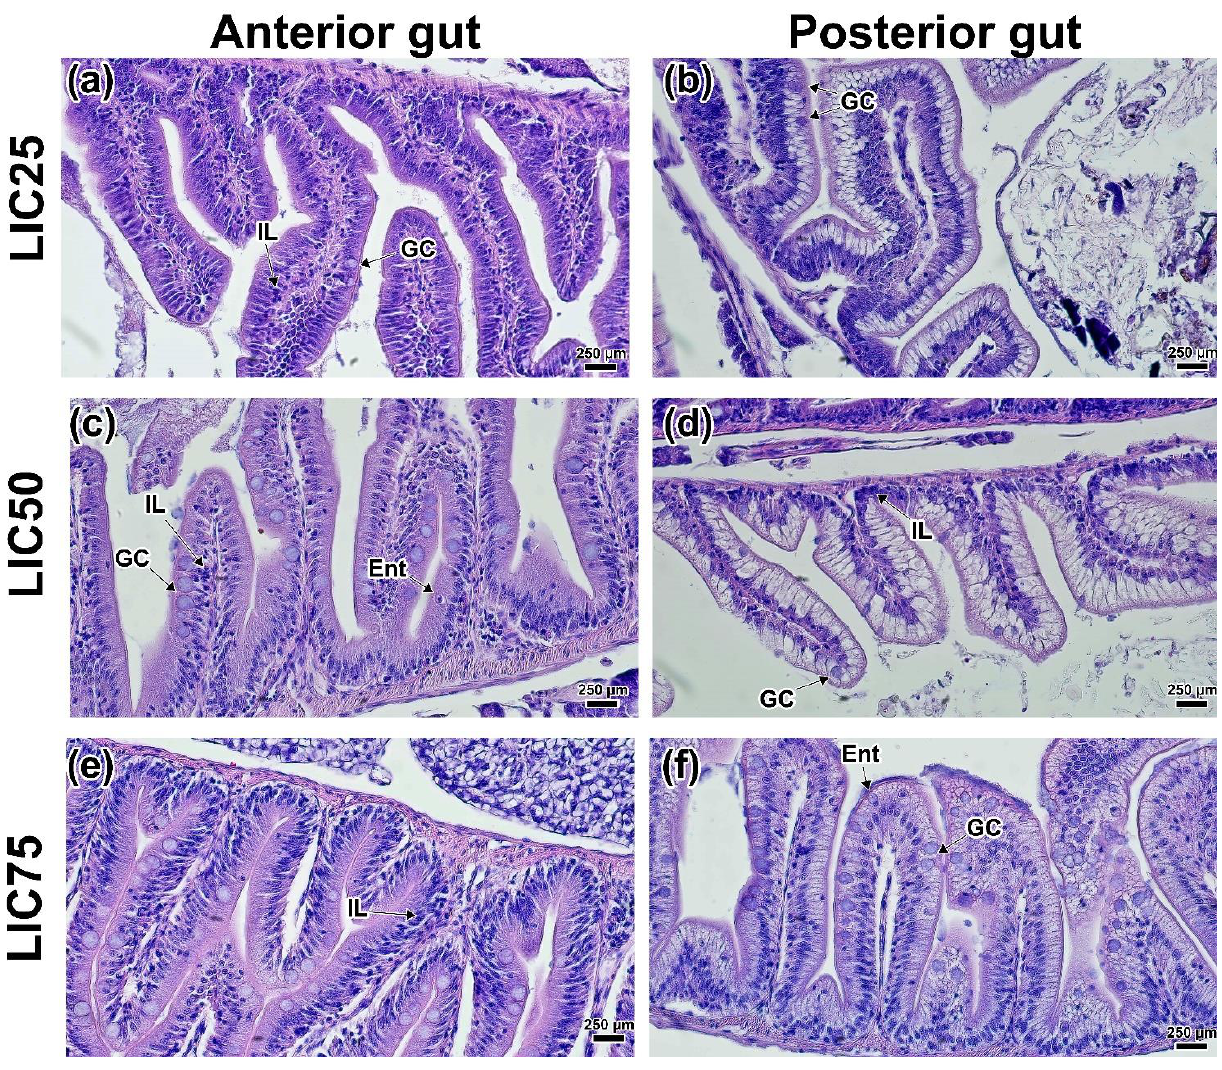
Figure 6. Histology of the anterior ( a , c , e ) and posterior ( b , d , f ) intestines of the D. rerio experimental groups receiving lycopene: ( a , b ) LYC25 group; ( c , d ) LYC50 group; ( e , f ) LYC75 group. LP — Lamina propria; GC — goblet cells; EN — epitheliocyte nucleus/columnar pseudostratified epithelium; IL